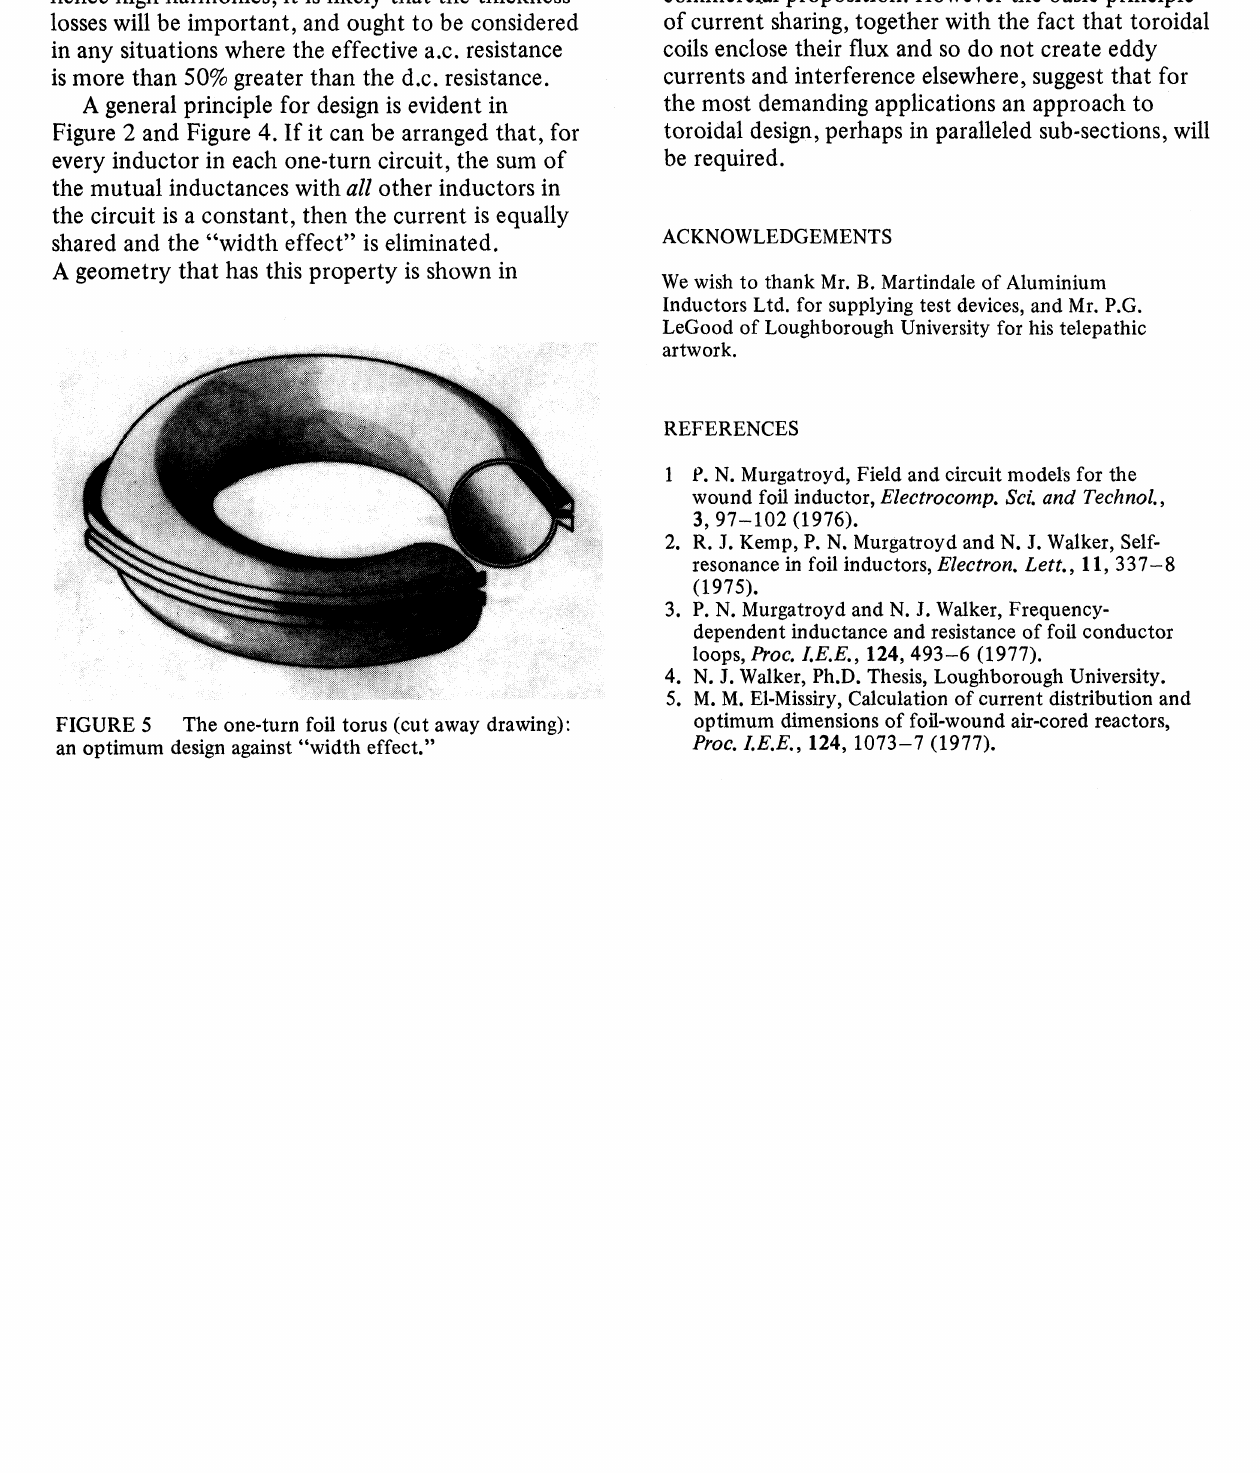
The one-turn foil torus (cut away drawing): an optimum design against "width effect."